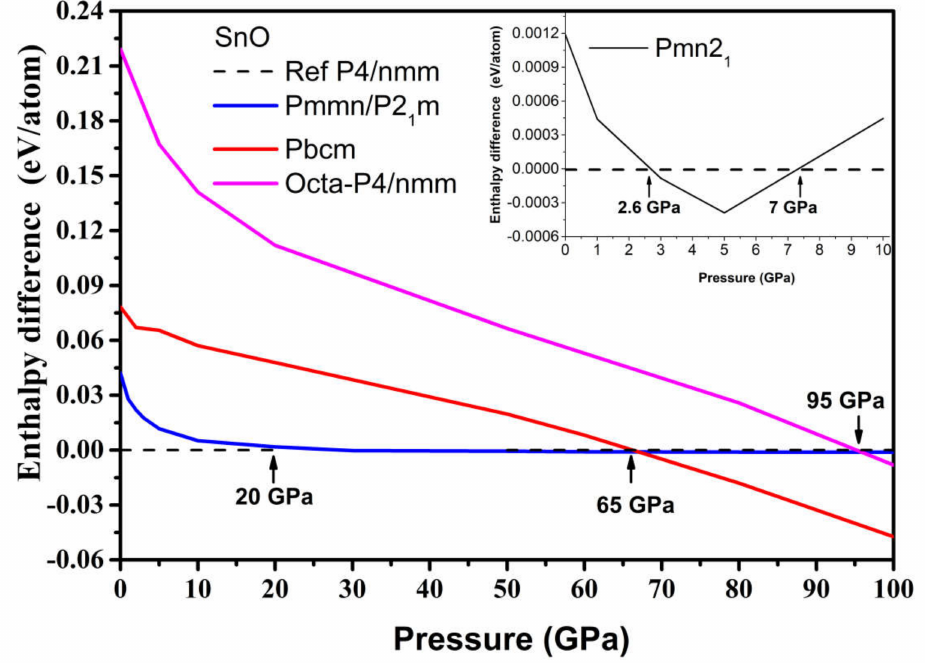
Figure 6. Enthalpy difference ∆ H of high-pressure SnO phases, where H GA is the total enthalpy of the GA phase, and H tetra is the total enthalpy of the reference tetragonal SnO. Inset: enthalpy difference for the Pmn2 1 phase of SnO at low